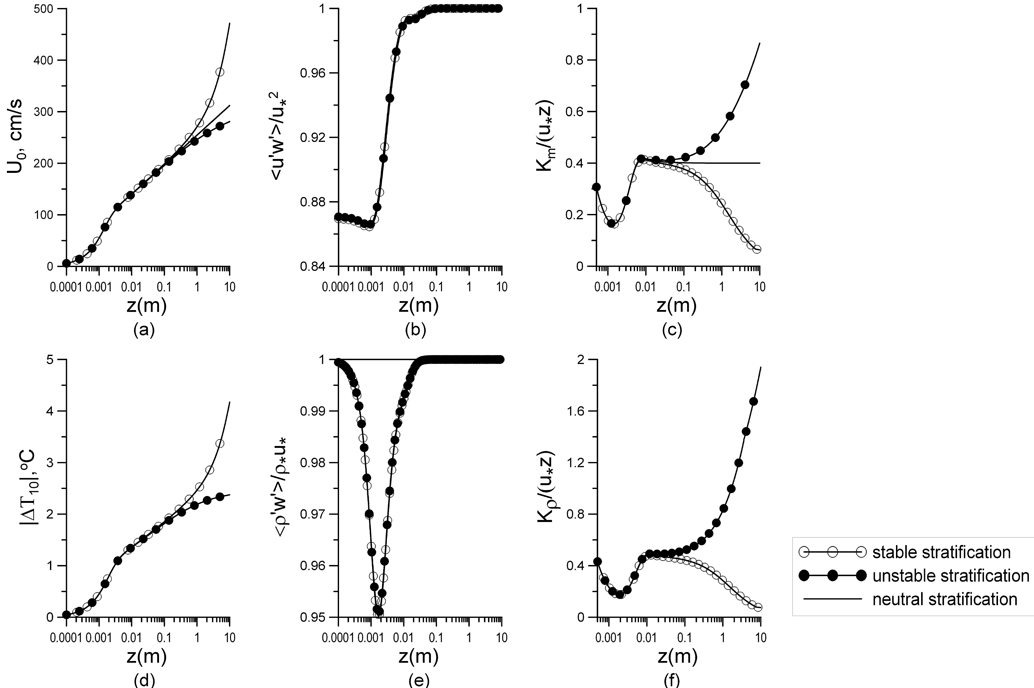
Fig. 1. Profiles of mean velocity (a) and temperature (d) , normalized turbulent momentum (b) and mass (e) fluxes, normalized turbulent momentum (c) and mass (f) transfer coefficients. Friction velocity is 10cms − 1 , density scale ρ ∗ /ρ a = ± 3 × 10 − 4 , k = 0 . 33cm − 1 , and kL = 100.